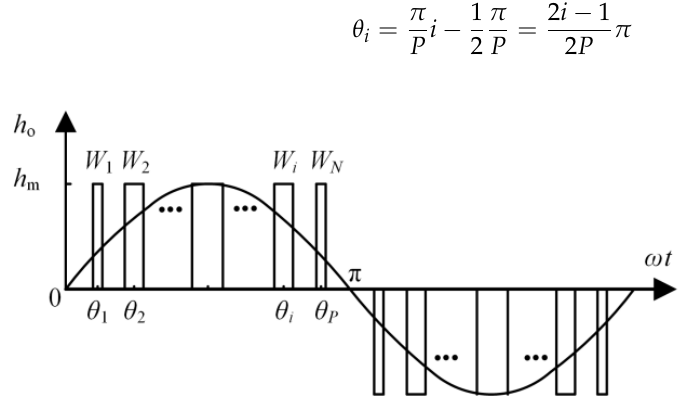
Figure 5. Theoretical waveforms of modulated and sin poles.